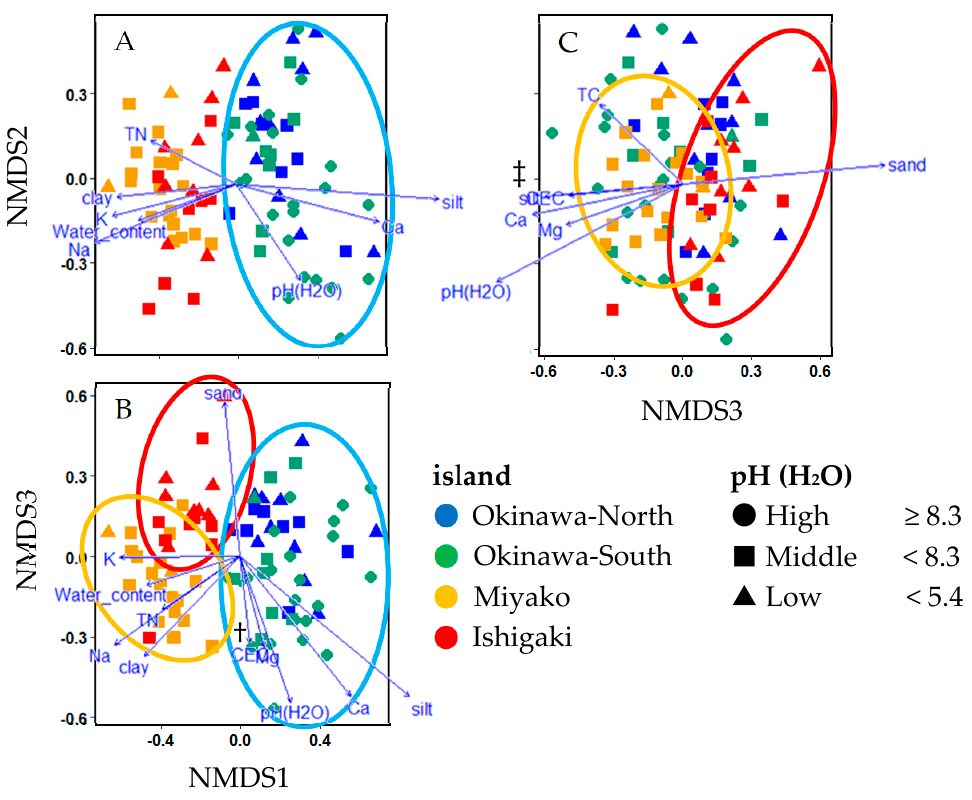
Figure 6. Non-metric multidimensional scaling (NMDS) plots for nematode community structures in four regions with environmental factors. A: dimension 1 and 2; B: dimensions 1 and 3; and C: dimensions 3 and 2. The graphs include significant ( p < 0.05) environmental factors, pH (H 2 O); clay; silt; sand; TC (total C); K (K + ); Na (Na + ); Ca (Ca 2+ ); Mg (Mg 2+ ) and CEC. The blue oval is in relation to Okinawa-North and South. The yellow oval is in relation to Miyako. The red oval is in relation to Ishigaki. ***, ** and * mean p < 0.001, 0.01 and 0.05, respectively. †: Mg 2+ and CEC; and ‡: silt and CEC.